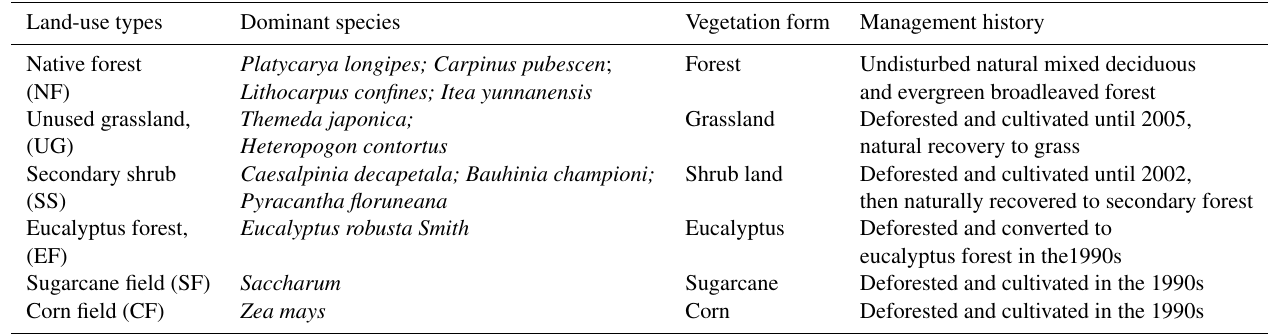
Table 1. The general information of land-use types selected in this study. Land-use